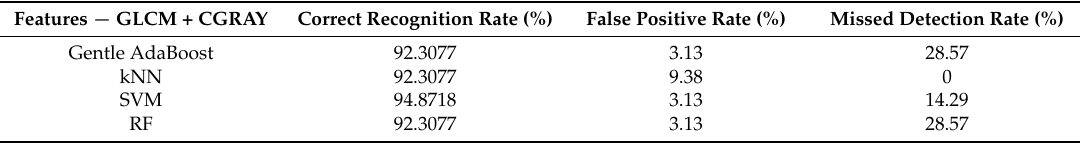
Table 7. Experimental results of constructing different recognition models based on Gray Level Co-occurrence Matrix (GLCM) + CGRAY features.